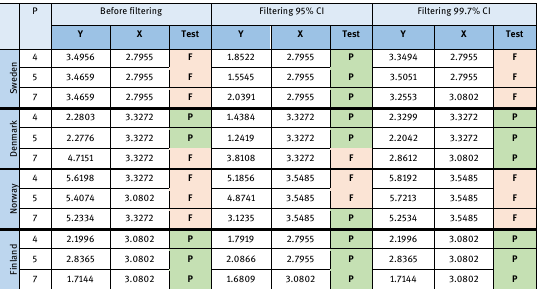
Table 4. Chi-square GOF test of the estimated residuals before and after least-squares detrending of filtered and nonfiltered discrepan- cies [unitless]